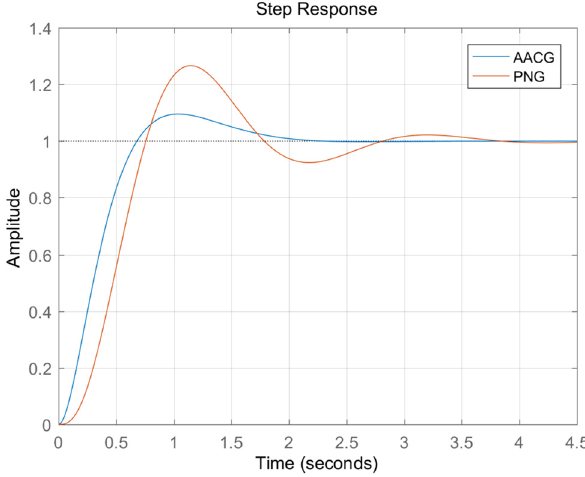
Figure 7: Bode diagram of open loop system, t go = 1 s.